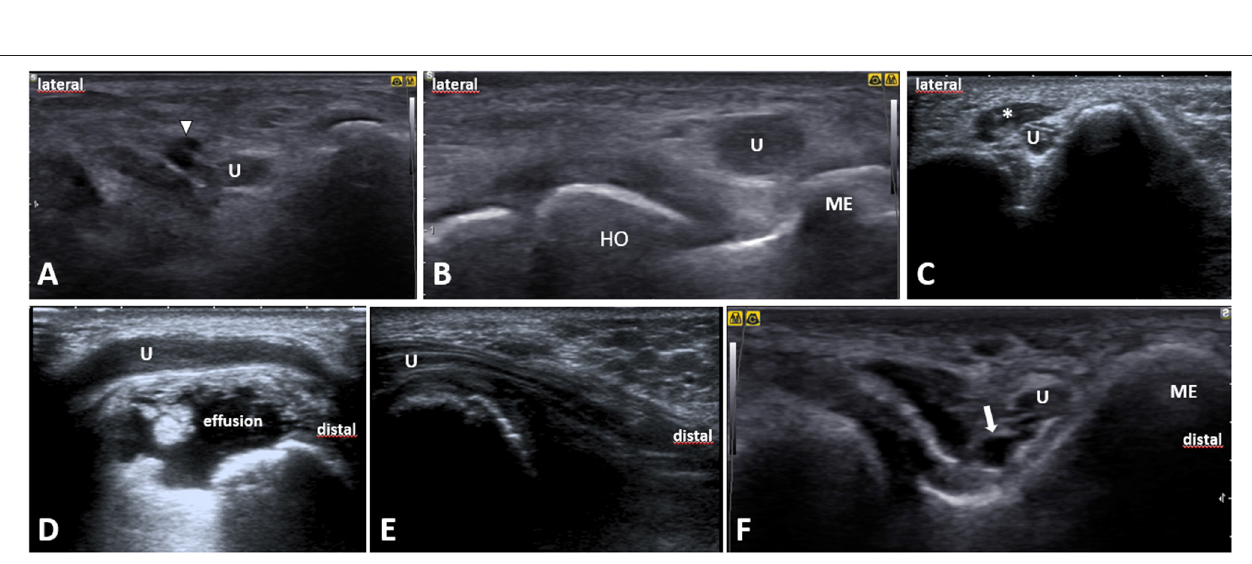
Frontiers in Neurology |